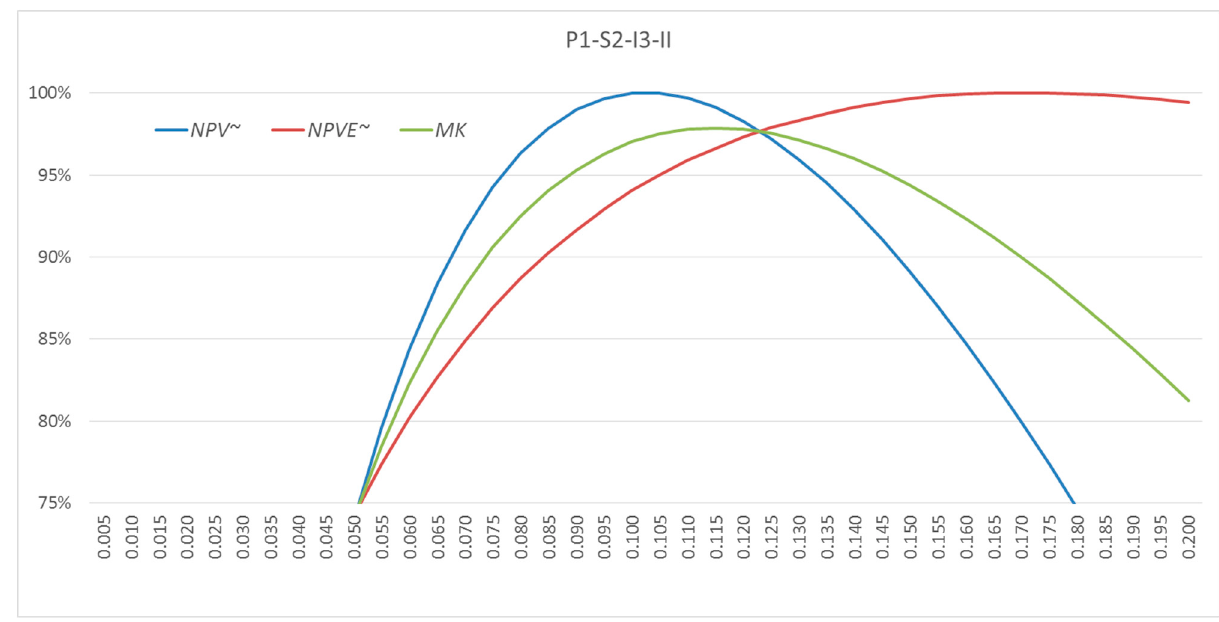
Energies 2021 , 14 , x FOR PEER REVIEW 11 of 16 Figure 2. NPV ~ , NPV E ~ and MK values depending on the thickness d for Variant P1-S2-I3-II. Figure 2. NPV ~ , NPV ~ and MK values depending on the thickness d for Variant P1-S2-I3-II. E